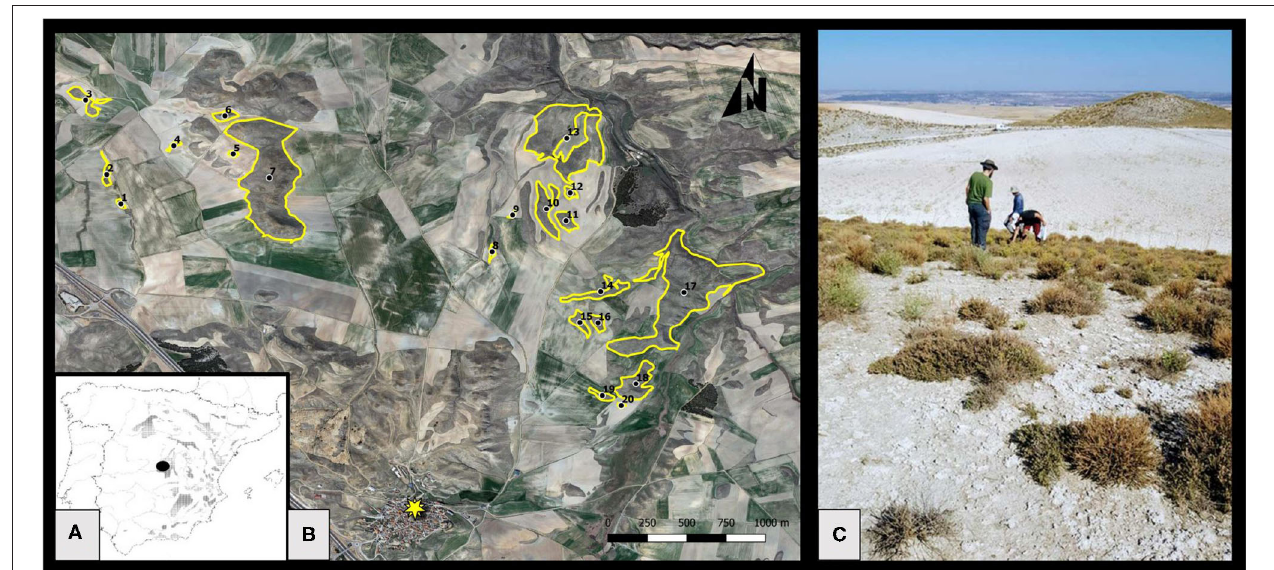
FIGURE 1 | (A) Map showing the distribution of gypsum outcrops of the Iberian Peninsula, re-drawn from Escavy et al. (2012), and the study area location (black dot). (B) Studied habitat remnants. The black dots indicate the centroid of each remnant, and the yellow star indicates the village of Belinchón. Note that the area includes other habitat remnants that were not sampled. However, all remnants were considered for the calculation of the connectivity index of the sampled ones. (C) General view of the study area showing a habitat remnant on the forefront with typical gypsum shrubby vegetation, another habitat remnant in the background, and a fallow field in the